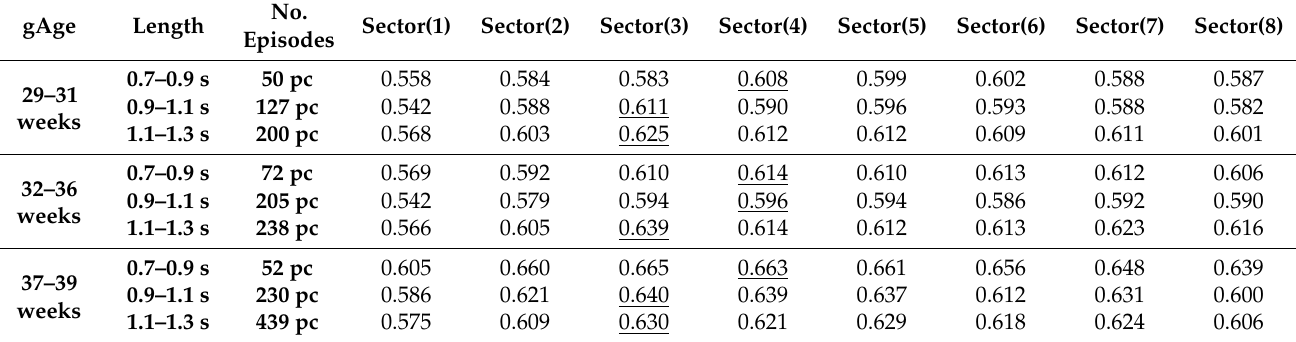
Table 2. The average sector intensity volume of FBM episodes.